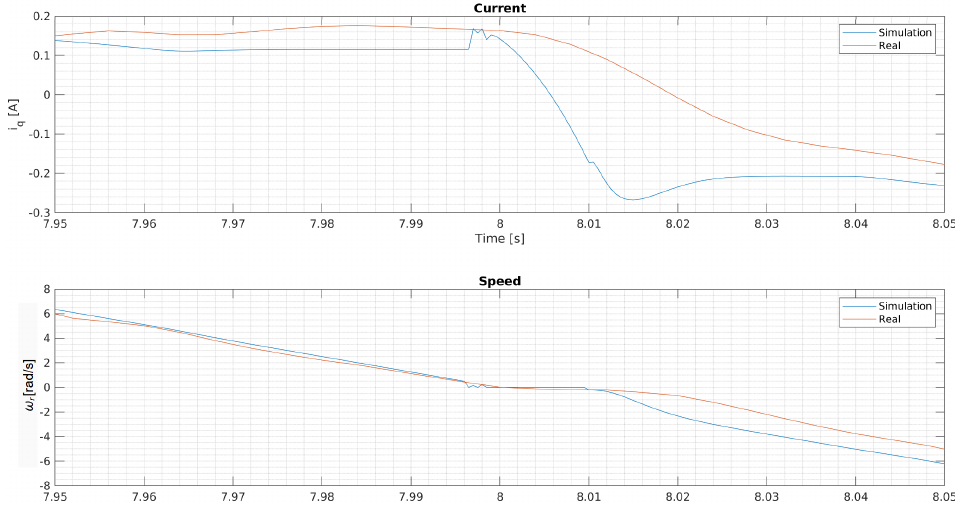
Figure 9. A detail of the transition from positive to negative speed during actuator